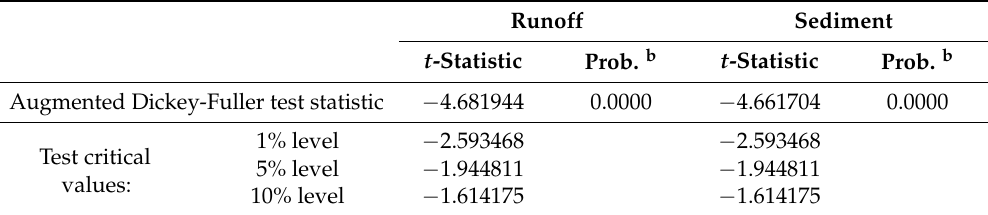
Table 3. ADF test results of residuals removing the seasonal effect and the tendency a